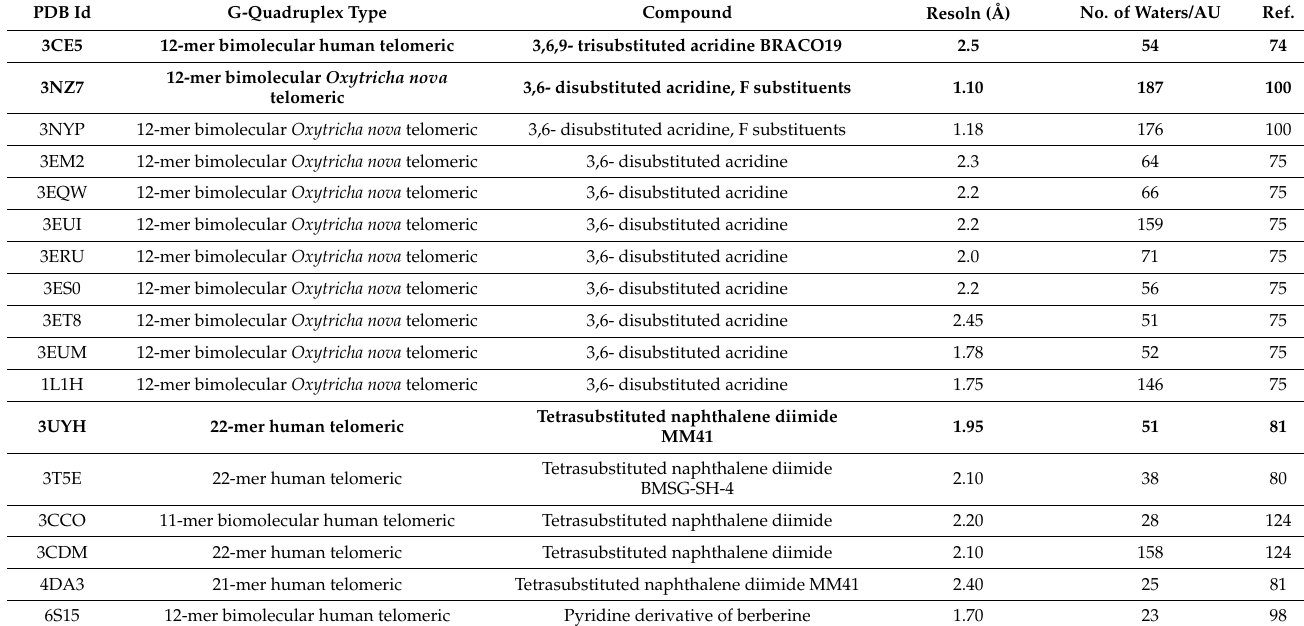
Table 1. G-quadruplex-small molecule crystal structures, taken from the Protein Data Bank, for which at the minimum a first shell of water molecules around the DNA and ligand have been reported. The number of water molecules associated with each complete G-quadruplex is quoted, as taken from the PDB entry. The structures discussed here (PDB ids 3CE5, 3NZ7 and 3UYH) are highlighted in bold.